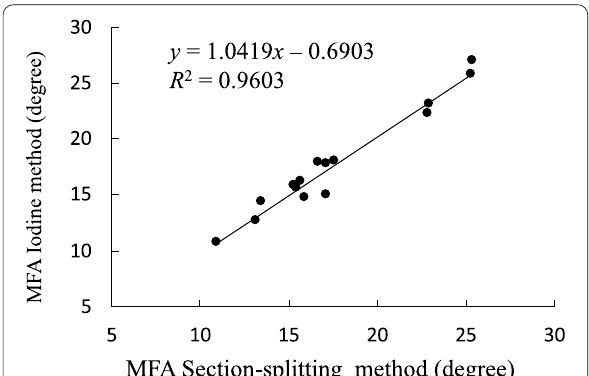
Fig. 2 Relationship between the MFAs measured by different methods. Sections were obtained from earlywood, transition wood from early to latewood and latewood in the ring numbers 3, 7, 11, 15, 19 and 23 of a sugi cultivar